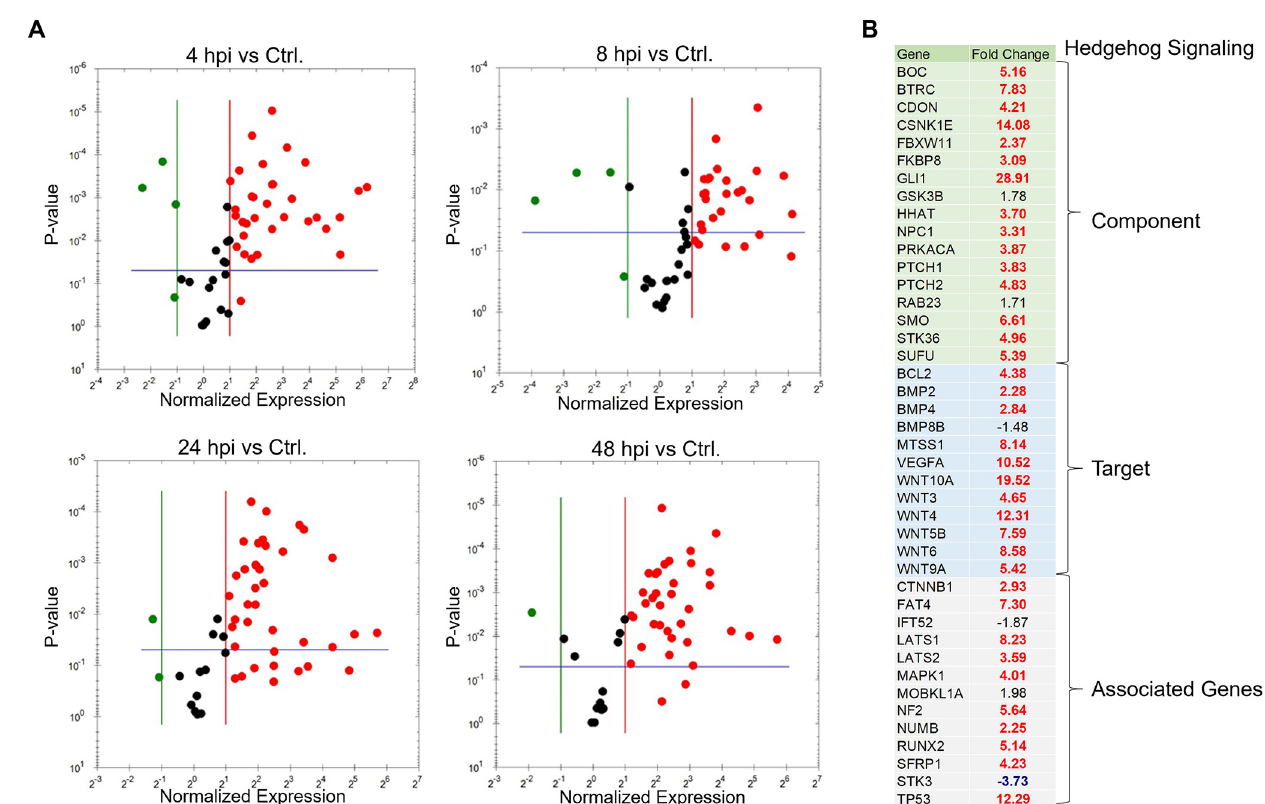
Fig 5. Expression array analysis of Hh-signaling genes during E . chaffeensis infection. (A) Volcano plots showing the differential expression of Hh-signaling pathway genes between E . chaffeensis- infected (MOI 100) and uninfected THP-1 cells at 4 h (top left), 8 h (top right), 24 h (bottom left) and 48 hpi (bottom right). The red, black and green dots in the volcano plot represent upregulation ( � 2), no change, and down-regulation ( � -2), respectively. The horizontal blue lines on the volcano plots determine the level of significance ( � 0.05). Genes were significantly upregulated at all time points. (B) Normalized expression of Hh array genes in component, target and associated gene categories between E . chaffeensis- infected and uninfected cells at 48 hpi. Cells were harvested with three biological and technical replicates for all time points.